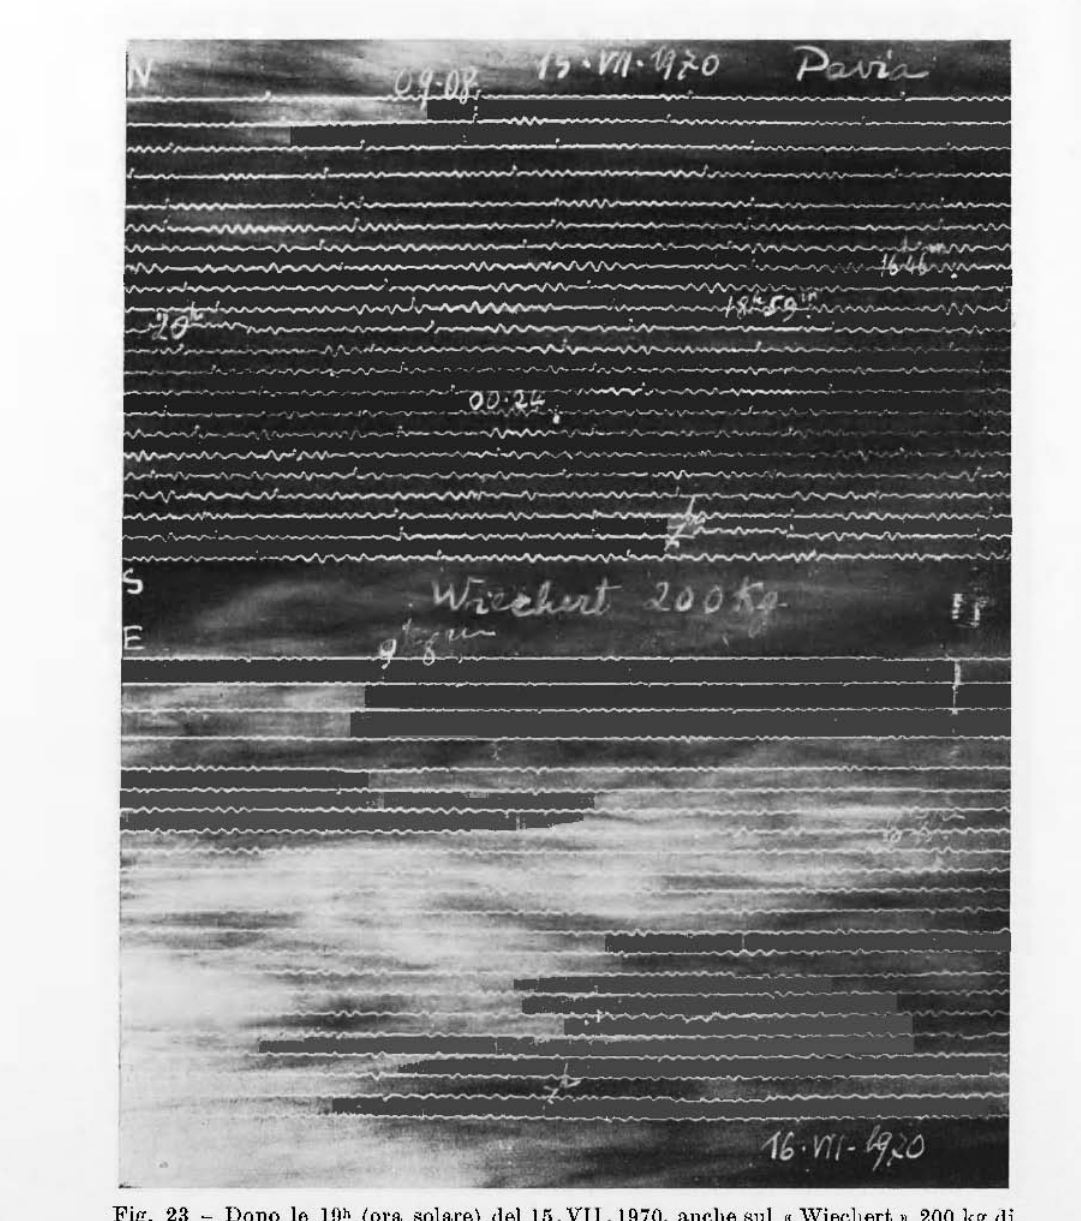
Fig. 23 - Dopo le lflh (ora solare) de115. Vll.19iO, anche sul . Wiechert . 200 kg di Pavia (a ca. 340 km di distanza) Bi ha registraziono di microsismi provenienti dal golfo di Trieste. EBsi però sono proceduti (e, in gran parte, sopraffatti) da microsismi (con periodi dell'ordino di 3-,5.3>,7) provenienti dal Mar Ligure, ed ivi provocati dalla stessa perturbazione, in transito parecchio ore prima (fig. 2). Fig. 23 - After 7)0 p.m. (Solar Time) of July }:;, 1970, the 200 kg "Wiechert" of Pavia, too, at about 340 krus distance, gave a recording of microseisms from the Gulf of Triesto, precedeù, howover, and covered to a largo extent by microseisms with periods in the order of 3",5·3",7 frOlli the Ligurian Sea where they had been cauBed when the sarne perturbation passed there a few hours